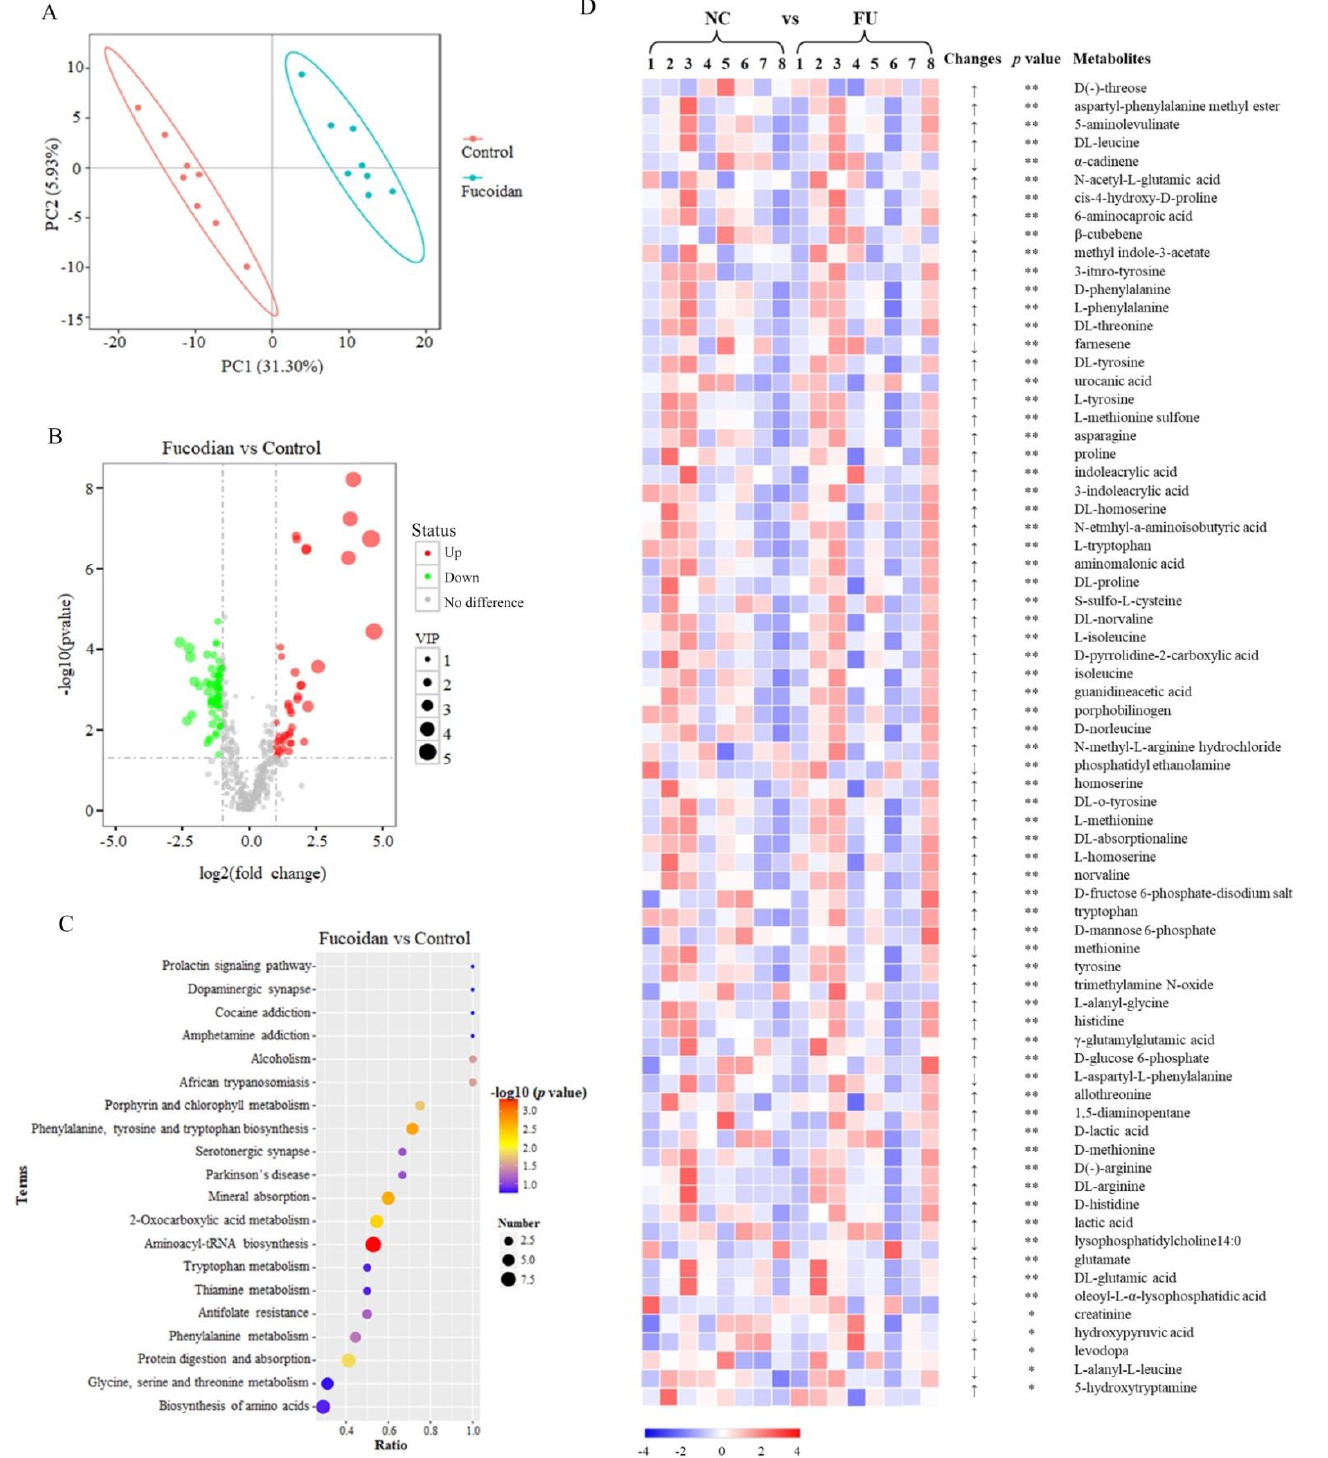
Figure A5. Analysis of fecal metabolites in mice ( n = 8). ( A ) Principal component analysis (PCA) and ( B ) volcano plot. Each dot represents one metabolite. Red dots represent the metabolites significantly upregulated and green dots represent the metabolites significantly downregulated by fucoidan treatment. The dot size represents the VIP value. ( C ) Metabolic pathways disturbed by fucoidan supplementation. The smaller the p value, the more reliable and statistically significant the test. ( D ) All the differential metabolites between the control and fucoidan groups. ↑ , upregulated by fucoidan administration after 10 weeks; ↓ , downregulated by fucoidan administration after 10 weeks. * p < 0.05, ** p < 0.01.